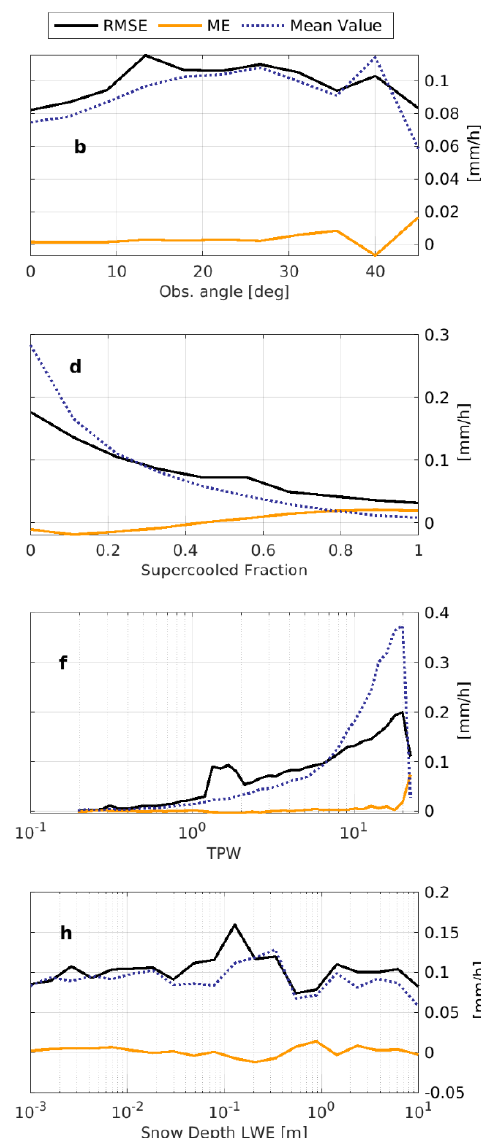
Figure 9. Sensitivity of the snowfall detection and surface snowfall rate estimate (SD and SRE modules) for different variables. Left panels show the statistics for the detection of snowfall (POD, FAR, and number of dataset observations), right panels present similar statistics considering RMSE, mean error, and mean value of snowfall rate. Panels from top to bottom show the sensitivity of the statistical indexes with respect to the observation angle ( a , b ), supercooled fraction ( c , d ), total precipitable water ( e , f ), and snow-cover depth ( g , h ).